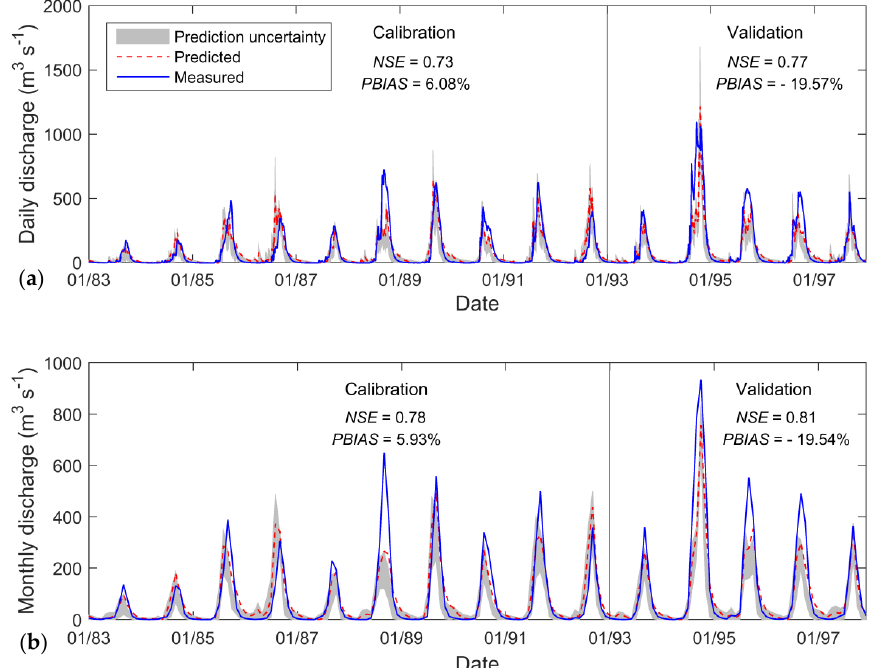
Figure 5. Simulated and observed hydrographs at Pankourou station at ( a ) daily and ( b ) monthly time steps along with calculated statistics on calibration and validation periods.